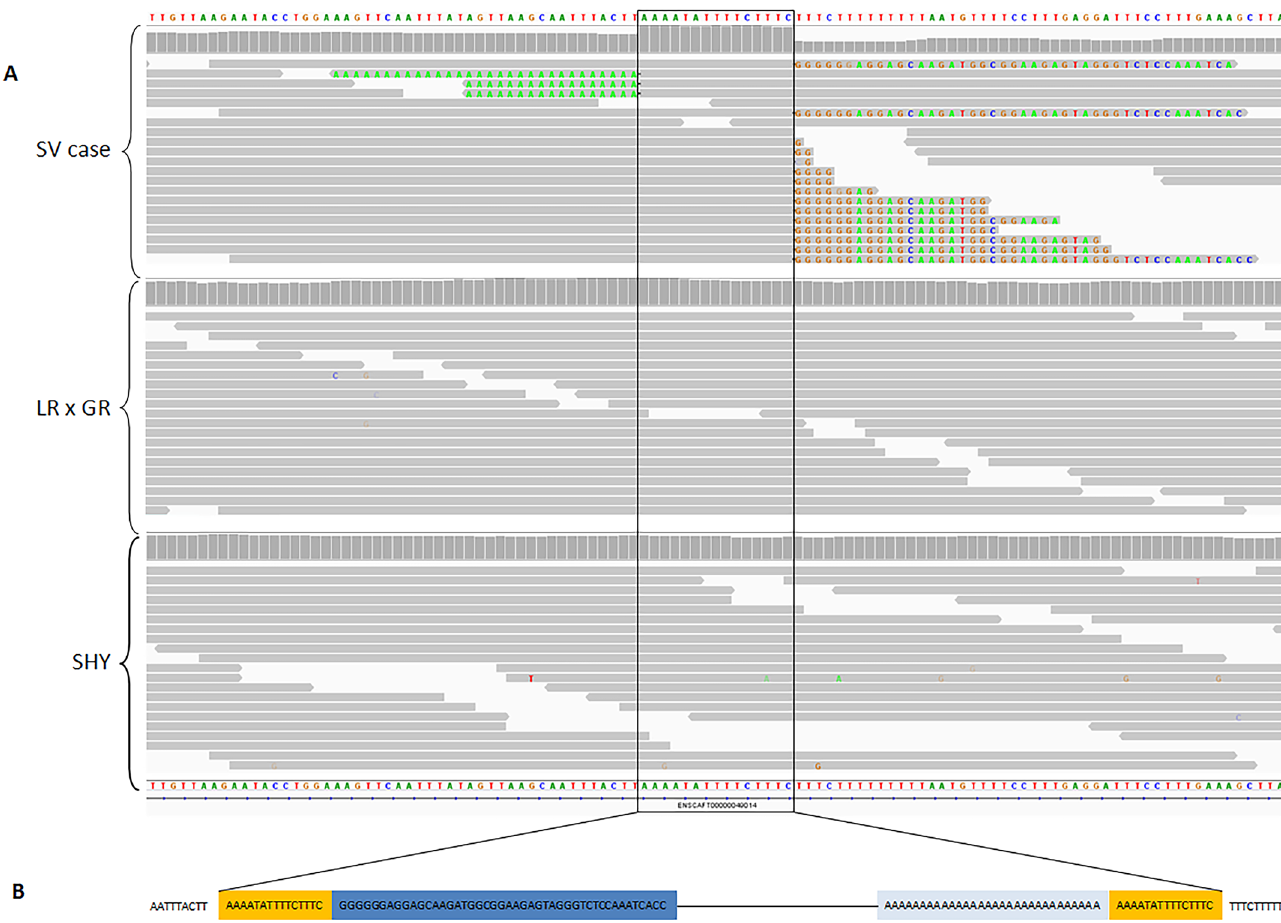
Fig 1. IGV Illustration of the LINE-1 insertion in intron 1 of the MERTK gene. A . The upper panelshows the SwedishVallhundcase, and the middle and lower panels representtwo control WGS for comparison(a Labrador-Golden retriever cross and a SiberianHusky, respectively). The 15 bp duplicatedsequencethat is the LINE-1 insertionpoint is boxed. The CanFam 3.1 reference sequence(Boxer) is shown above and belowthe figure. B . Diagram to clarify the LINE-1 insertionin the SwedishVallhundcase. The 15 bp duplicationis shownin orange,and soft-clipped bases in sequence reads at the start and end of the LINE-1 insertion(from the upper panel of A ) are shown in dark and light blue, respectively.The line joiningthese two sequencesrepresents the 6.401 kb of LINE-1 insertion sequence.